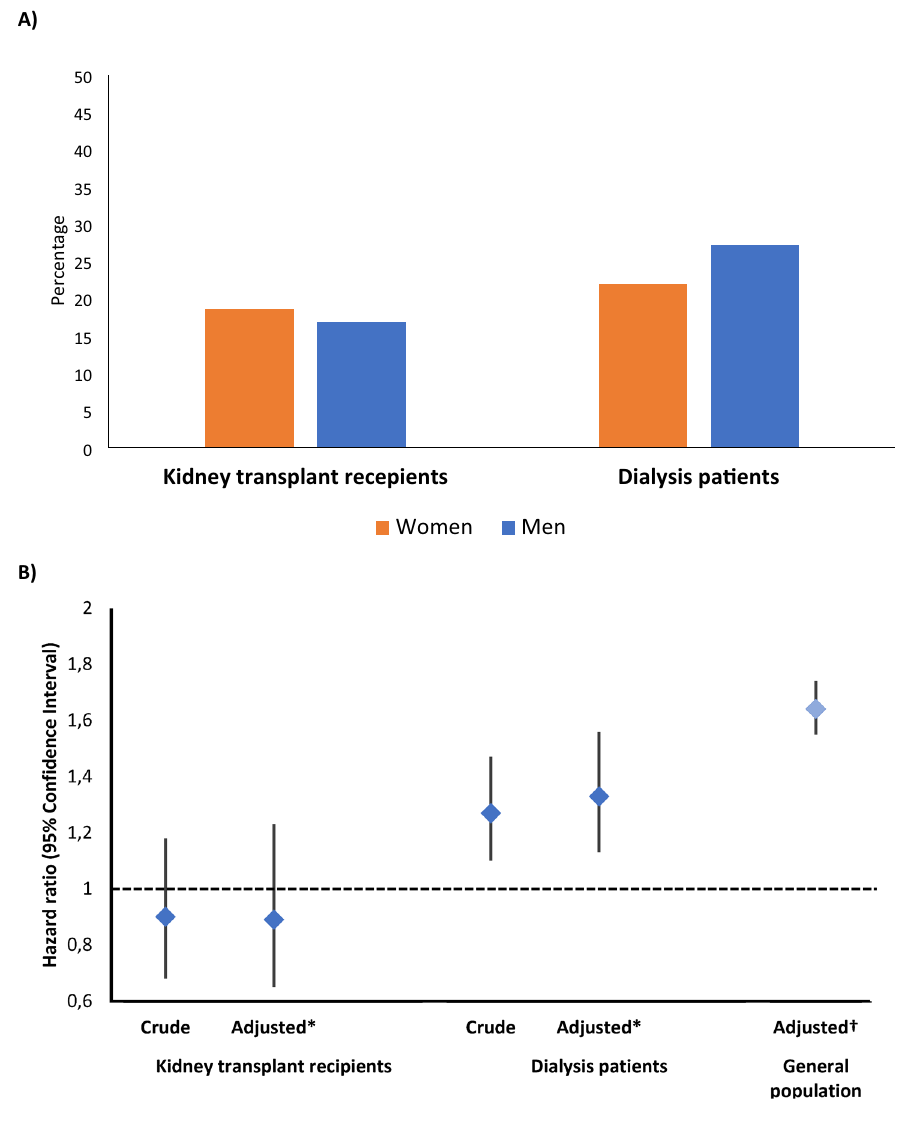
Figure 1. Percentage mortality by sex and type of kidney function replacement therapy ( A ) and hazard ratio for the association of sex (male vs. female (reference)) with 3-month mortality by type of kidney function replacement therapy ( B ). *Adjusted for: age (continuous), clinical frailty score (continuous), the reason for COVID-19 screening (symptoms-based screening, positive COVID-19 contact or routine screening), smoking (never, current, former), obesity (yes/no), hypertension (yes/no), diabetes (yes/no), heart failure (yes/no), chronic lung disease (yes/no), coronary artery disease (yes/no), and auto-immune disease (yes/no), duration of kidney function replacement therapy (years) and estimated glomerular filtration rate (continuous). †